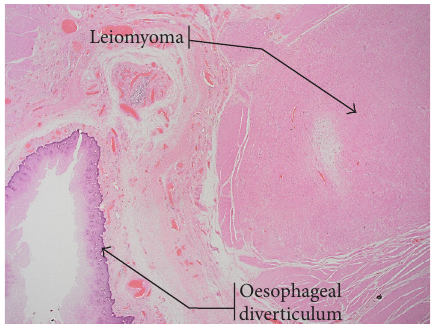
Figure 4: Histological view showing leiomyoma and oesophageal diverticulum. Haematoxylin & eosin stain ×